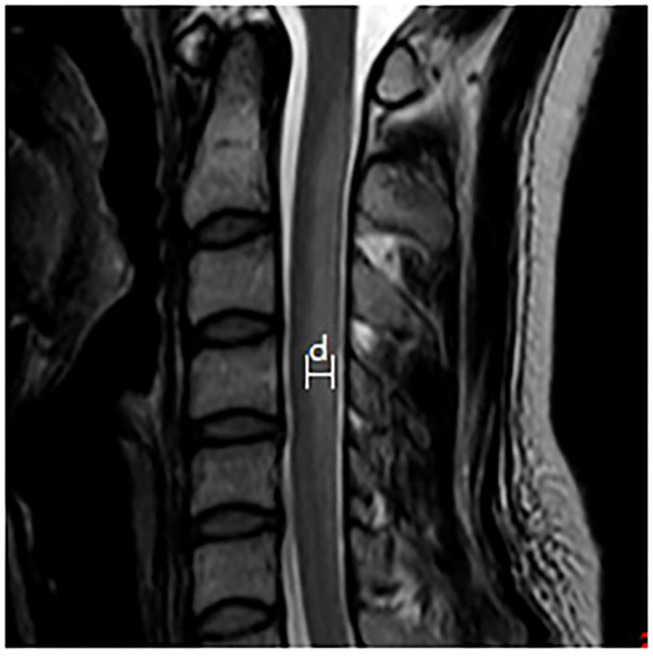
Schematic diagram of the lesion width that was measured. The maximum width between the anterior-posterior margin of the lesion in the midsagittal T2WI image is measured to provide the width of the lesion.